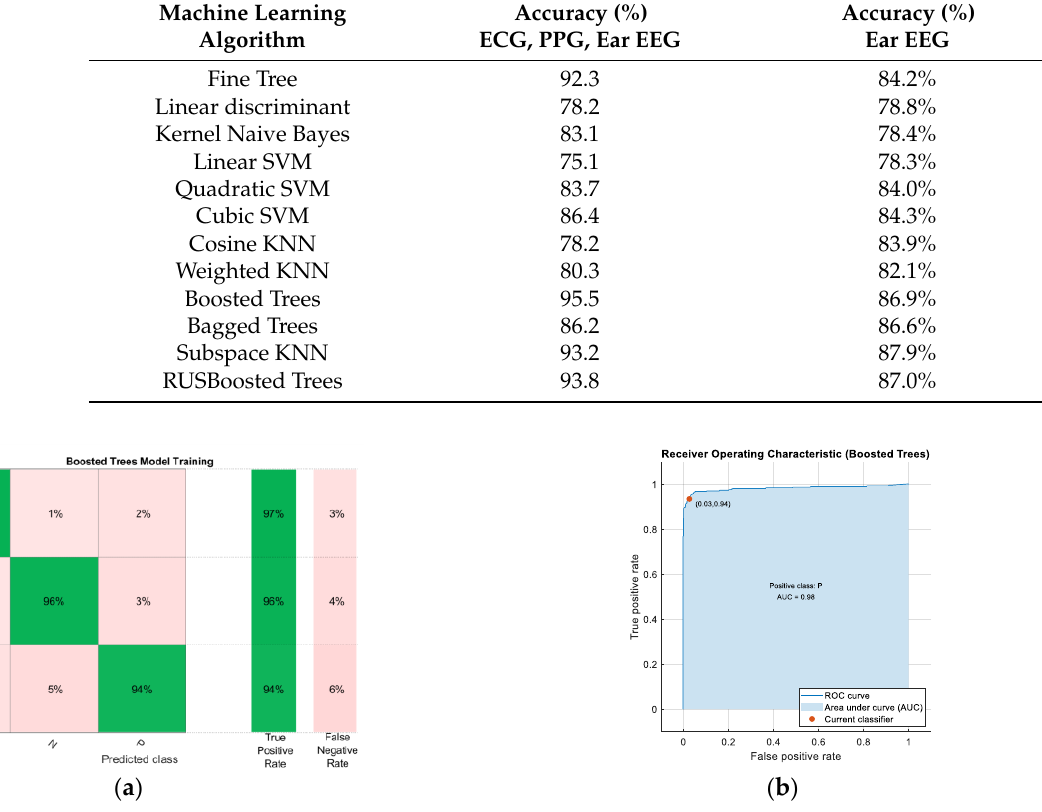
Figure 7. ( a ) Confusion matrix of the Boosted Trees model after training; ( b ) Receiver Operating Characteristic (ROC) curve and its respective Area Under Curve (AUC).